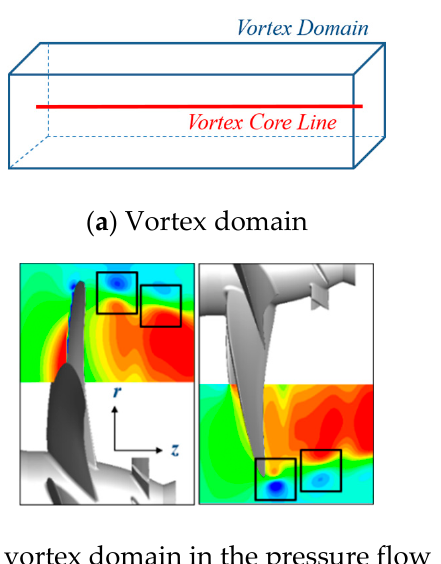
( b ) tangential velocity profile Figure 15. Schematic diagram to define the maximum tangential velocity and initial core radius of the vortex regenerated using the vortex model. ( a ) Distribution of the velocity component in the x - direction on a plane normal to mean flow. ( b ) Distribution of x -directional velocity on the lines of the constant azimuthal angle passing through the point of the maximum radial gradient of x -direction velocity. After the vortex core trajectory and the properties of the vortex model are determined, the domains where the tip vortex is reconstructed need to be defined. Figure 16 shows the vortex domain constructed for each blade, together with its construction process. The vortex domain is constructed by using the cuboid of the square cross-section, whose center coincides with the vortex core line, as